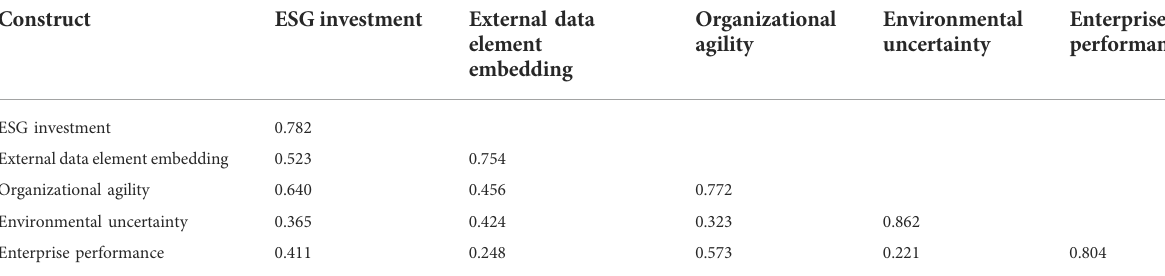
TABLE 2 The discriminant validity test of the scale.